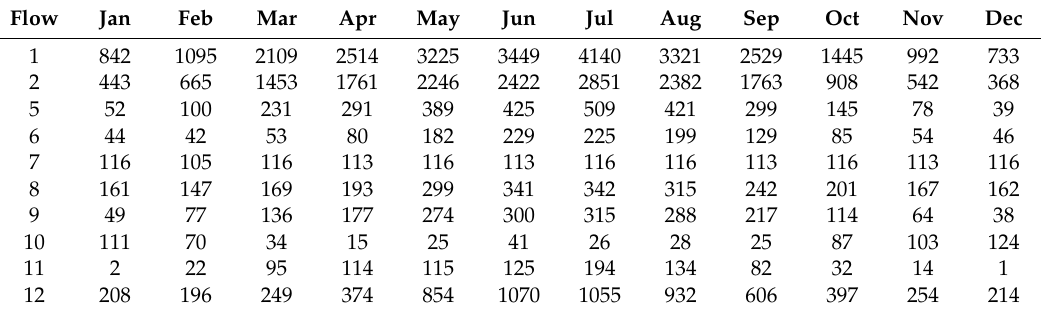
Table 3. Monthly energy balance of the solar parabolic trough–ORC analyzed plant (system B), MWh /